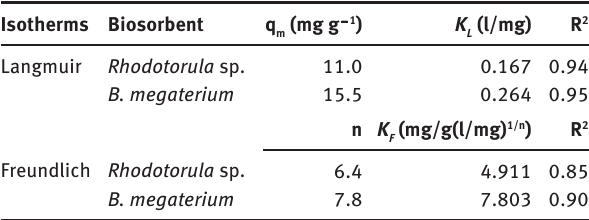
Table 2: Isotherms parameters obtained for Cd(II) removal by Rho- dotorula sp. and Bacillus megaterium .